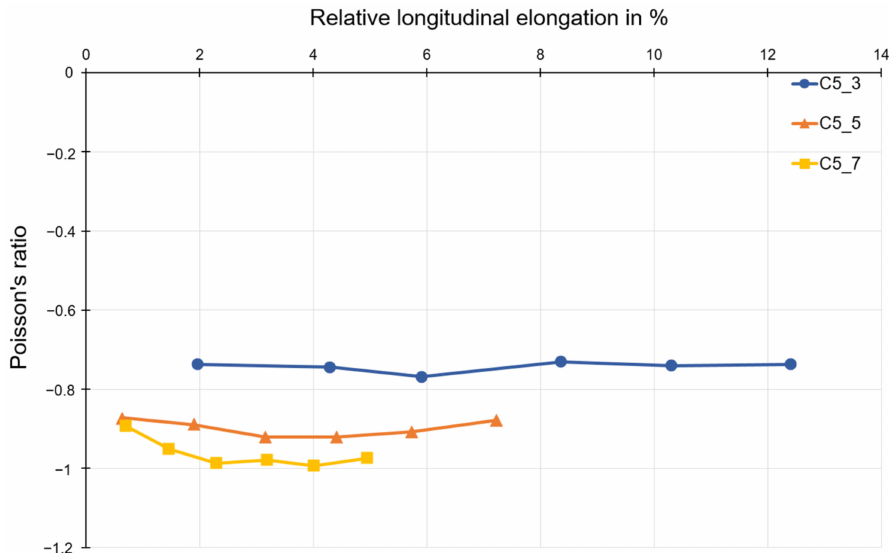
Figure 13. Poisson’s ratio as a function of longitudinal strain for test specimens made of compound C5. For polymer C1, as shown in Figure 14, the Poisson’s ratio decreases with increasing longitudinal elongation. Poisson’s ratios in the range of about − 0.8 to − 1.0 are also obtained for polymer C1, as for polymer C6 and compound C5.